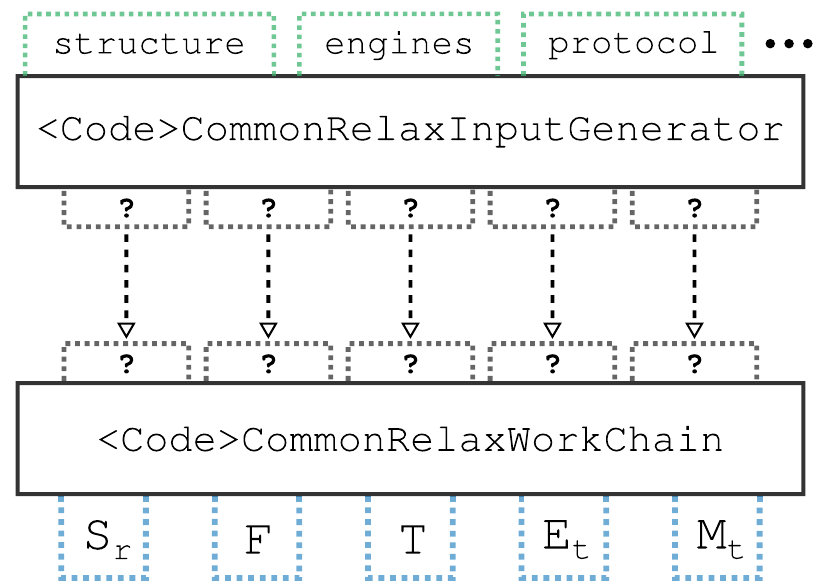
Fig. 3 Schematic diagram of the common relax work fl ow interface. Any implementation consists of two parts: the <Code>CommonRe- laxWorkChain and a <Code>CommonRelaxInputGenerator . The <Code>CommonRelaxWorkChain is an AiiDA WorkChain that implements the logic necessary to perform the structure optimization and has an input interface that is code-speci fi c. However, the outputs that it returns respect the schema of the common interface, where S r is the relaxed structure, F are the forces on each atom, T is the stress on the cell, E t is the total energy and M t is the total magnetization of the system. Each <Code>CommonRelaxWorkChain provides its own <Code>CommonRelaxInputGenerator which, unlike the work fl ow, implements the common interface for the inputs (note that not all common inputs are shown for clarity). Here structure is the structure that is to be optimized, the protocol is a string that de fi nes how the inputs are determined, and the engine is a dictionary that speci fi es what code(s) to use. The <Code>CommonRelaxInputGenerator translates the common inputs into the code-speci fi c inputs that the corresponding <Code>CommonRelaxWorkChain expects (indicated with ? ). Since the creation of the code-speci fi c inputs and the launching of the work fl ow are two separate actions, the generated inputs can be adapted at